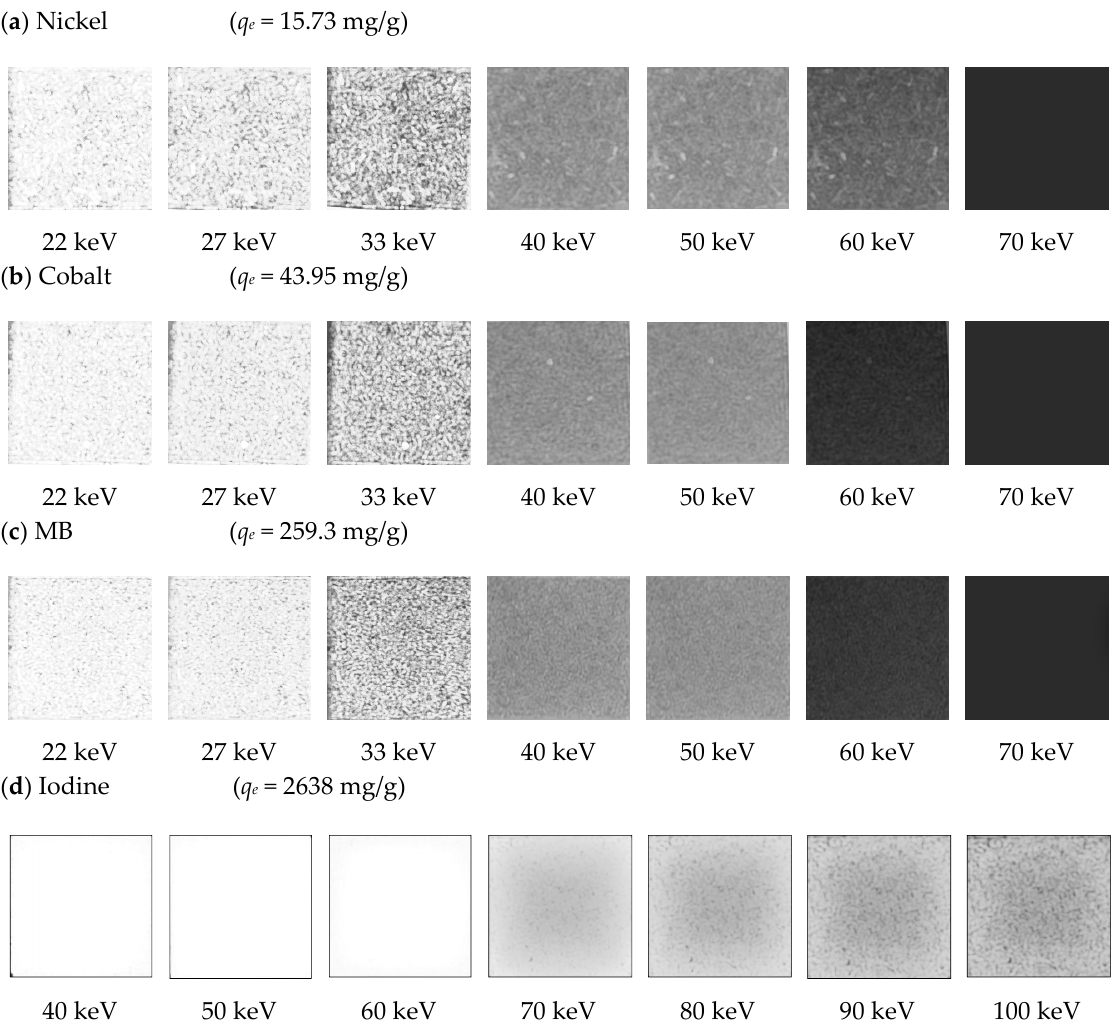
Figure 4. Digital radiographies taken at different energies for each adsorbed molecule/element onto GAC using different q e values: ( a ) for nickel; ( b ) for cobalt; ( c ) for MB and ( d ) for iodine.